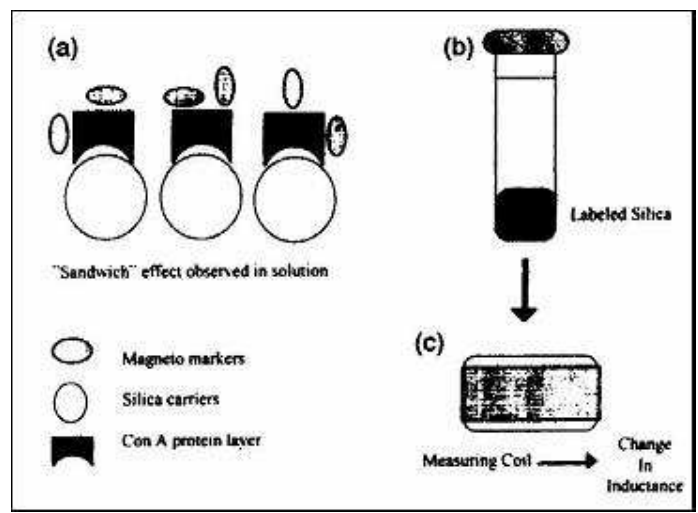
Figure 7. The ‘sandwich’ approach used for in the magneto binding assay ( Reprinted from [21] with permission from Elsevier